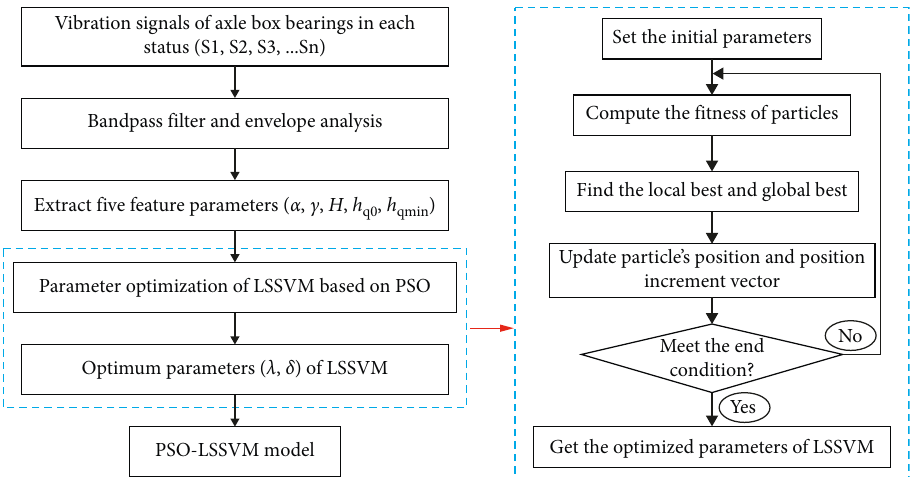
Figure 6: The detailed process of building the PSO-LSSVM model.